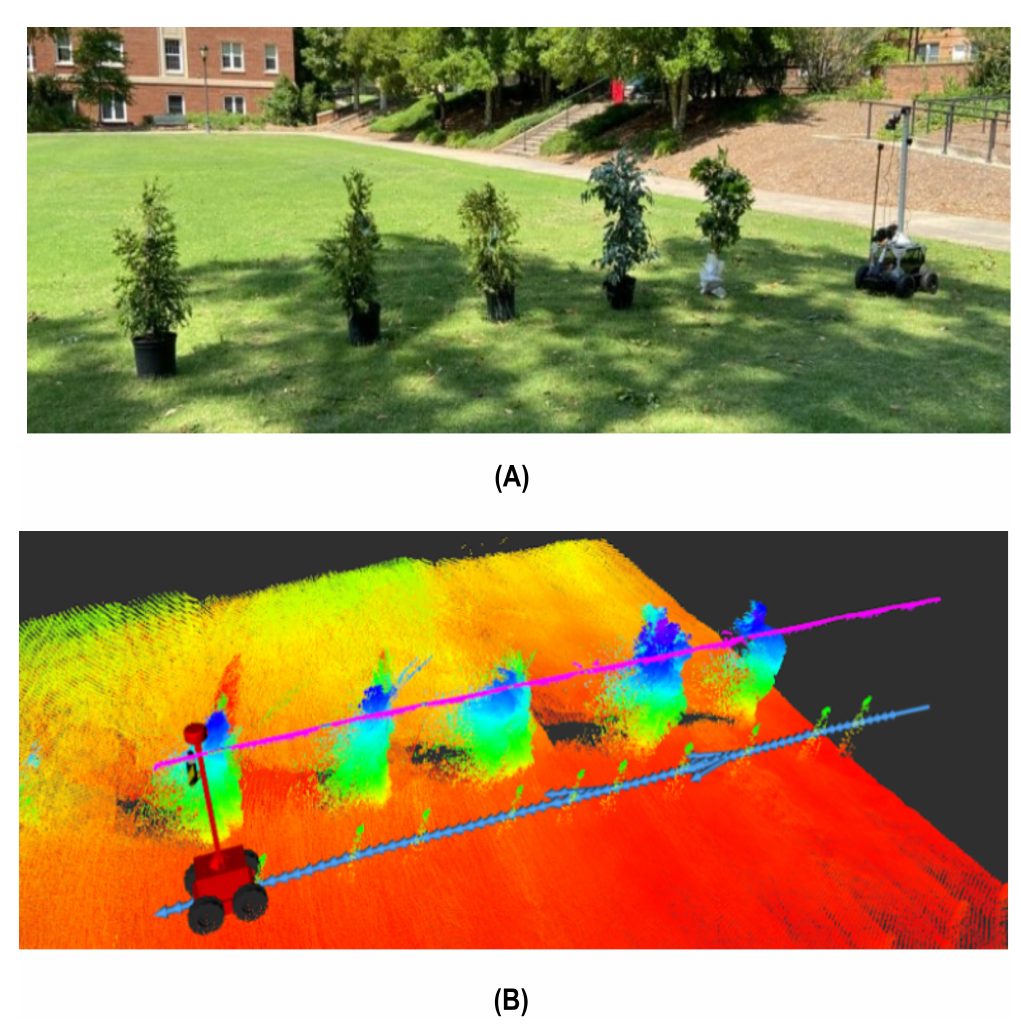
Figure 14. LiDAR phenotyping testing setup and data visualization. ( A ) A picture of the test set-up and ( B ) visualization of the LiDAR data using